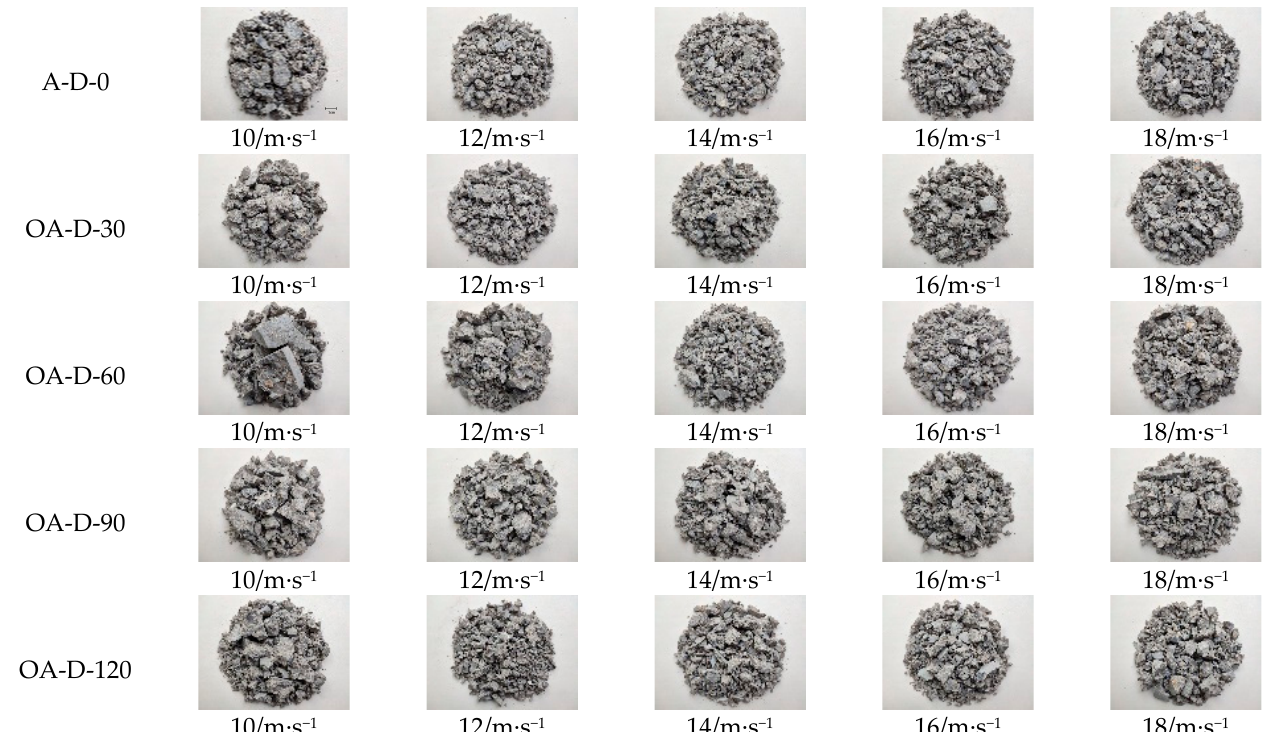
Figure 5. Impact failure modes of test pieces at different